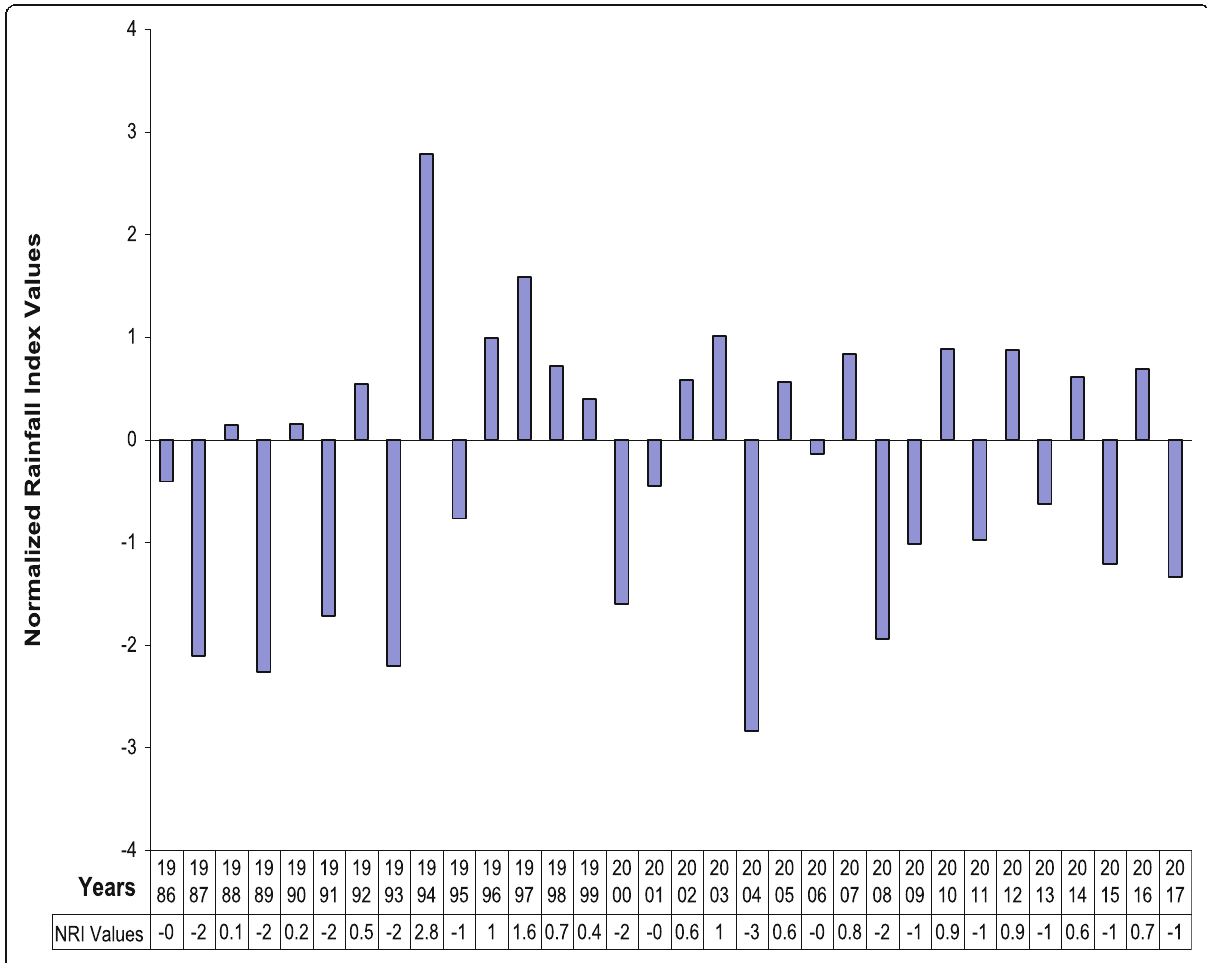
Fig. 2 Normalized rainfall index for Nguru station (Data source: Nigerian Meteorological Agency Abuja